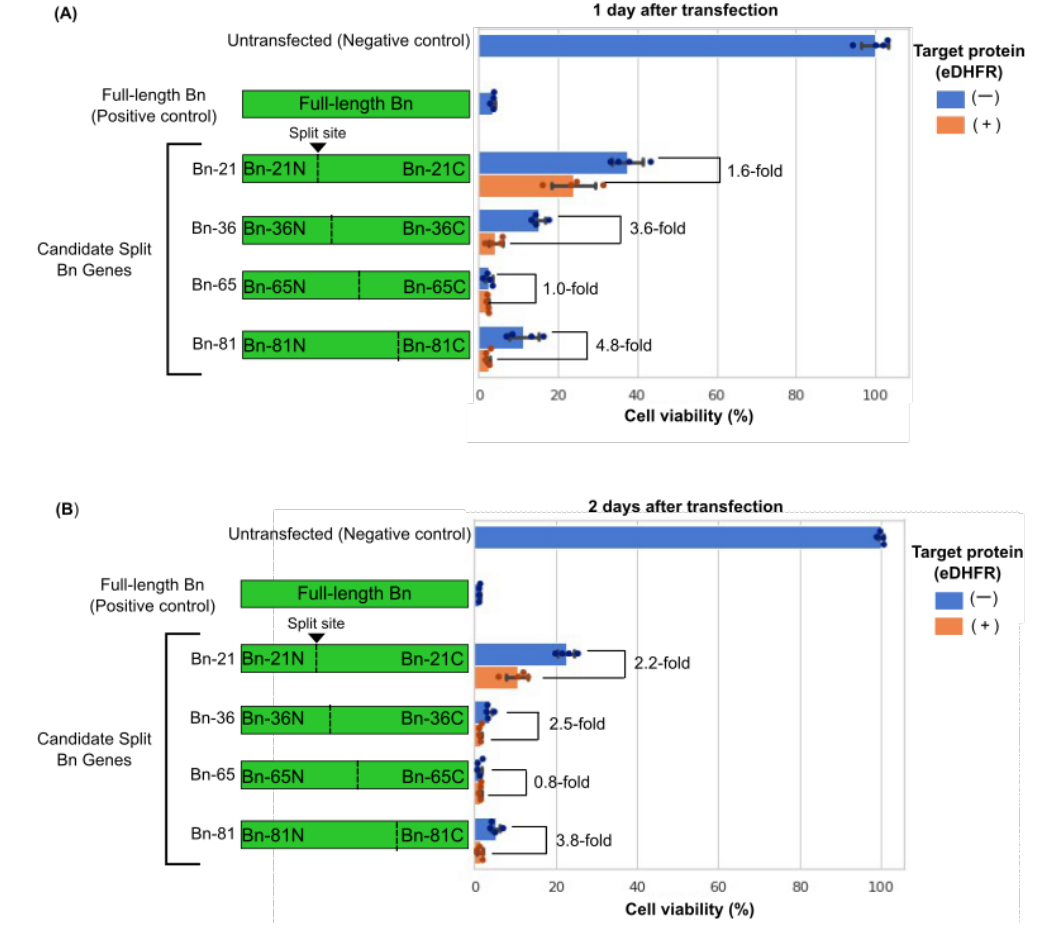
Figure 2. Cell viability assay results comparing the selective cytotoxicity of each candidate split Bn set. ( A ) Cell viability 1 day after transfecting candidate split Bn sets. HeLa cells were cotransfected with each of the N- and C-terminal split Bn sets (45 ng/well of each) and eDHFR mRNA (10 ng/well). Full-length Bn (90 ng/well) was used as a positive control. ( B ) Cell viability 2 days after transfecting candidate split Bn sets. Despite Bn-81 showing the highest fold change between the on- and off-target con- ditions, only approximately 5% of cells in the off-target condition lacking the target pro- tein were not eliminated (Figure 2B). We speculated that a small portion of split Bn was reconstituted into full-length Bn by the target protein-independent protein splicing and that the off-target cytotoxicity results from such reconstituted full-length Bn. To reduce this off-target cytotoxicity, we cotransfected Bn-81 with Barstar, a protein sterically inhib- its Bn by forming a one-to-one, noncovalently bound complex (Figure 3A) [19 – 21]. The smallest amount of Barstar mRNA necessary to reduce off-target cytotoxicity was evaluated. Cotransfection of 3, 2, or 1 ng of Barstar mRNA with Bn-81 resulted in nearly 100% viability of target protein-lacking cells, while high cytotoxicity was still ob- served in the target protein-expressing cells, especially when 1 ng of Barstar mRNA was used (Figure 3B). These results demonstrate the superiority of Bn-81 in its ability to